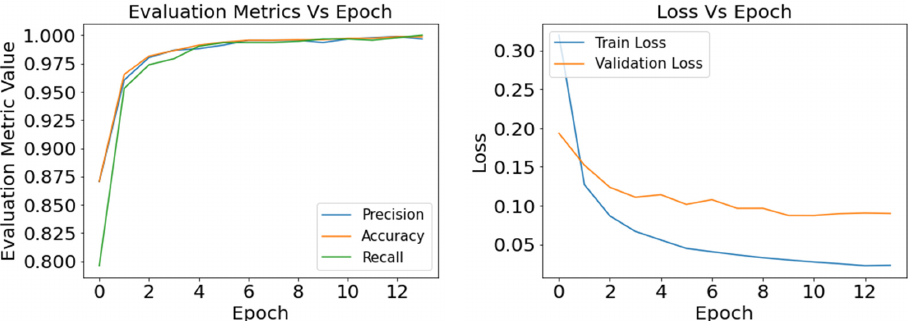
Figure 9. Defects classification with InceptionV3: result of the evaluation metrics and model loss for optimizer SGD and learning rate 0.01. After analyzing the model’s performances, the IceptionV3 model ranked as the best- performed model for defects classification. Moreover, this model reached its performance- optimized point owing to the SGD optimization function and learning rate of 0.001. Apart